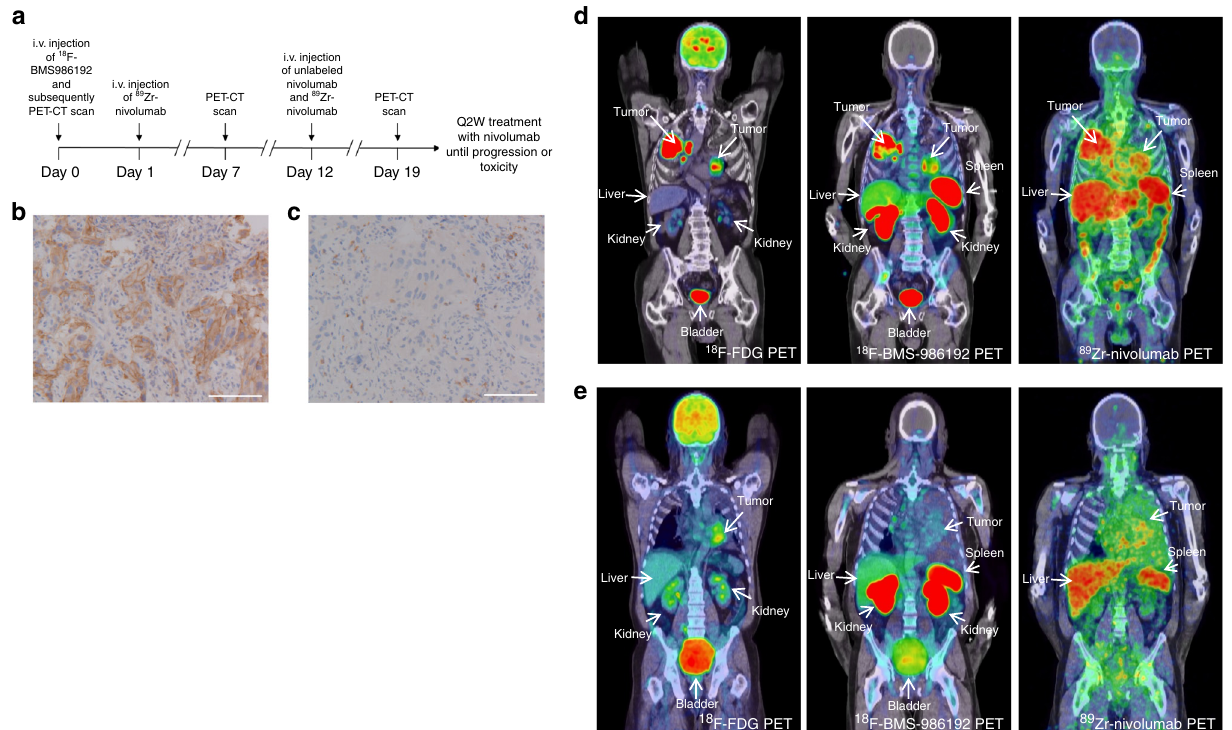
Fig. 1 Study design, immunohistochemical staining of patient 2, and PET-images of patient 2 and 3. a Study design. b Immunohistochemical staining of PD- L1 in patient 2. Biopsy of the tumor in the left lower lobe. PD-L1 expression is expressed in 95% of the tumor cells. Scale bar, 100 µ m. c Immunohistochemical staining of PD-1 in patient 2. PD-1 expression in aggregates was scored as IC1. Scale bar, 100 µ m. d 18 F-FDG PET (225 MBq) ( 18 F- FDG PET scan images of both patients were used from archival PET-scans) demonstrates high glucose metabolism of tumors in both lungs and mediastinal lymph nodes. 18 F-BMS-986192 PET (145.7 MBq, imaging time point 1 h post-injection (p.i.)) and 89 Zr-labeled Nivolumab PET (37.09 MBq, 162 h p.i.) demonstrate heterogeneous tracer uptake within and between tumors. e Patient 3 with tumor PD-L1 expression < 1%: 18 F-FDG PET (268 MBq) ( 18 F-FDG PET scan images of both patients were used from archival PET-scans) demonstrates high glucose metabolism in the left-sided tumor. 18 F-BMS-986192 PET (214.62 MBq, 1 h p.i.) demonstrates low tumor tracer uptake. 89 Zr-labeled Nivolumab PET (37.27 MBq, 160 h p.i.) demonstrates heterogeneous